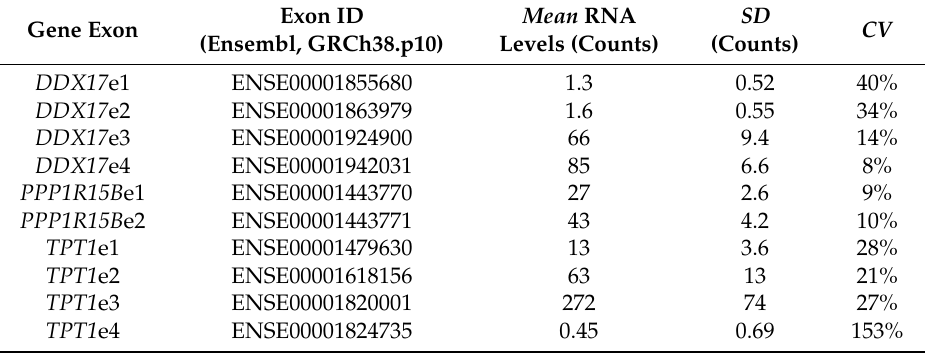
Table 2. Details of multiple exons in selected 1 genes detected in the RNA-seq dataset.